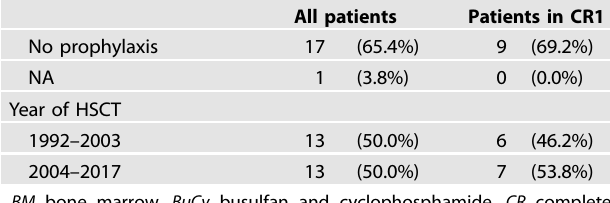
Table 1. Characteristics of patients in the syngenic